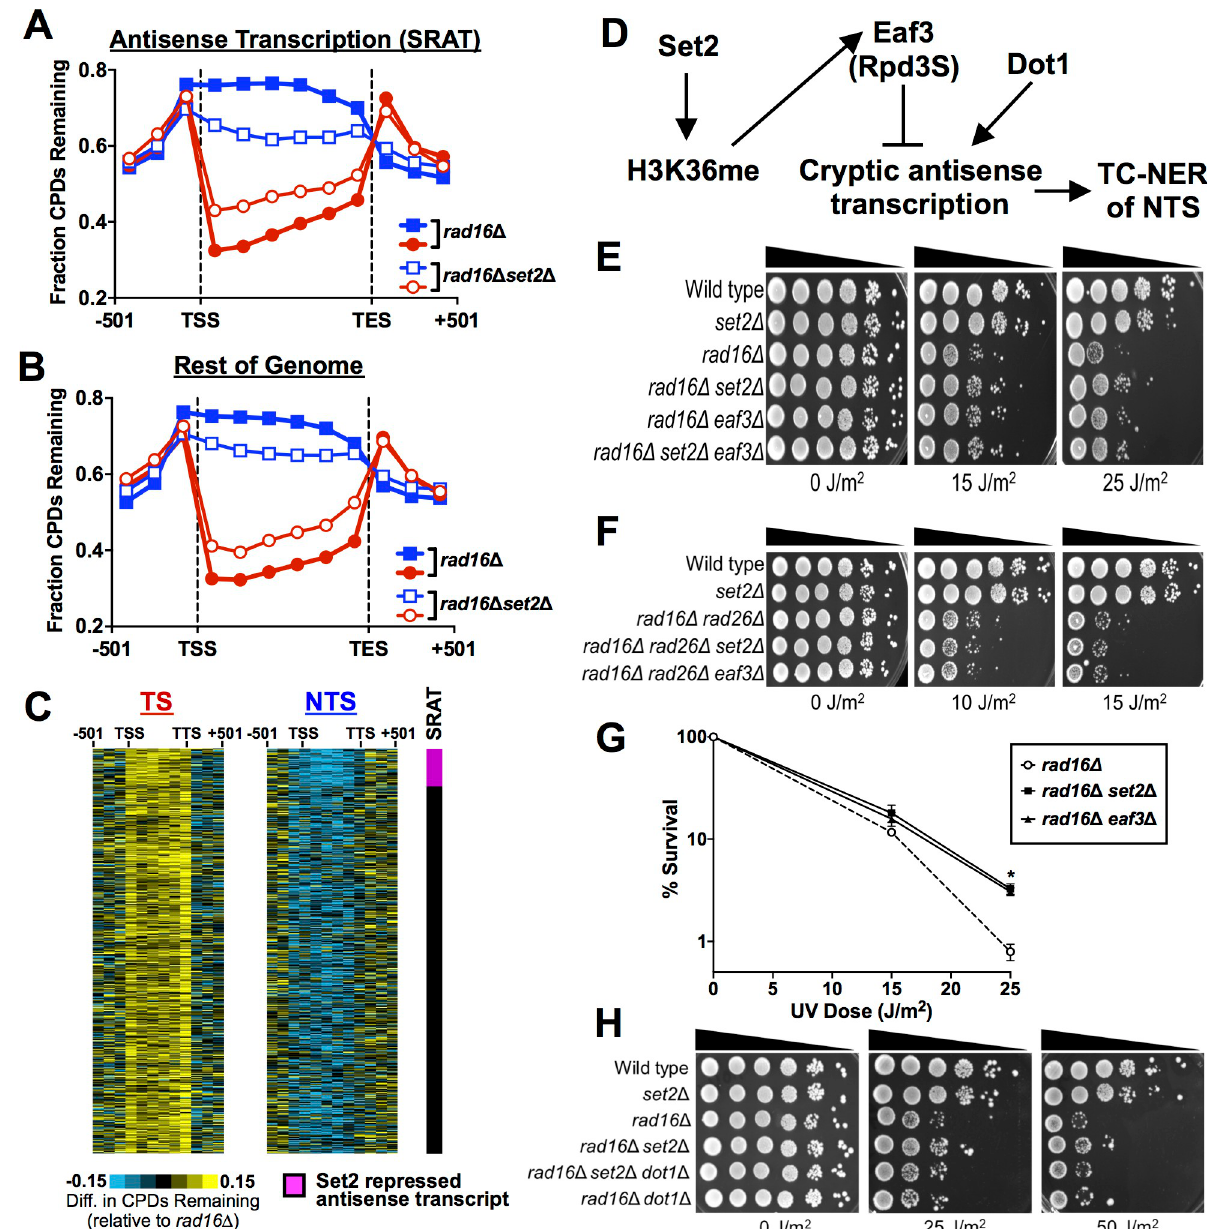
Fig 5. Loss of SET2 induces repair of the NTS particularly at genes with cryptic Set2-repressed antisense transcripts (SRATs). (A) The average fraction of CPDs remaining after 2hr of repair (relative to 0hr) was plotted for CPD-seq data for 463 genes with polyadenylated SRATs in rad16 Δ and rad16 Δ set2 Δ cells. List of polyA SRAT genes is from [46]. Red symbols/line indicates the transcribed strand (TS); blue symbols/line indicates the non- transcribed strand (NTS). (B) Same as panel A , except CPD-seq data is shown for all non-polyA-SRAT genes. (C) Gene plot analysis showing difference in the fraction of unrepaired CPDs following 2hr of repair along the TS (left panel) and NTS (right panel) of yeast genes in rad16 Δ set2 Δ cells relative to rad16 Δ cells. PolyA SRAT genes are sorted at the top of the gene plot. ( D ) Model of how loss of Set2 (or Eaf3) promotes TC-NER of the NTS by activating cryptic antisense transcription. Dot1 is required to activate cryptic transcription for many genes in a set2 Δ mutant [50]. (E,F) The indicated mutant yeast strains were serially 10-fold diluted, spotted, and exposed to specified UVC doses (G) Quantitative UV survival assay of the indicated yeast cells. The graph represents the quantification of UV survival from at least three independent experiments ± SEM. � P � 0.05. Source data is in S2 Data. ( H ) UV sensitivity assay (similar to panels E,F ) showing that Dot1, which is required for activation of cryptic transcription in a set2 Δ mutant (see panel D ), is also required for rescue of UV sensitivity in a rad16 Δ set2 Δ mutant.